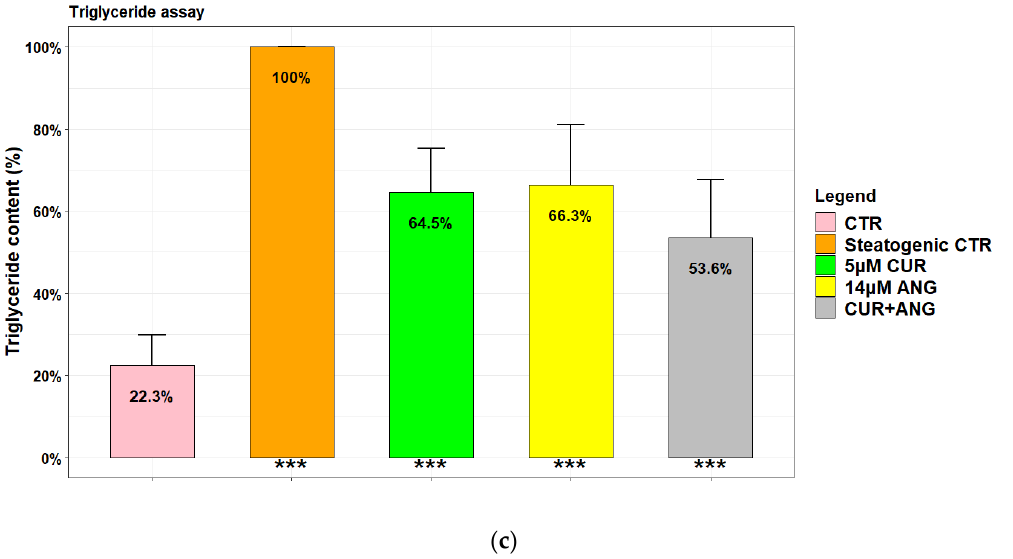
Figure 3. Curcumin (CUR, 5 µM), andrographolide (ANG, 14 µM), and curcumin + andrographolide reduce lipid content on HepG2 cells after steatosis induction (P/O) for 24 h as reported in Section 4. ( a ) Representative photographs showing the lipid droplets (LDs) reduction by Oil Red O (ORO) staining after the treatments (400 × original magnification) and LDs quantification by ImageJ; ( b ) quantitative ORO staining measured by spectrophotometer at 490 nm reading; ( c ) intracellular TGs content quantified by spectrophotometer at 570 nm. The results are expressed as the mean ± SD of six independent experiments. Level of significance: *** p < 0.001; ** 0.001 < p < 0.01; * 0.01 < p < 0.05; steatogenic control with respect to the control or treated cells with respect to the steatogenic control.